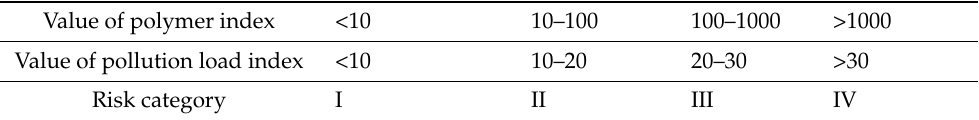
Table 2. Risk-level criteria for microplastic pollution [74].